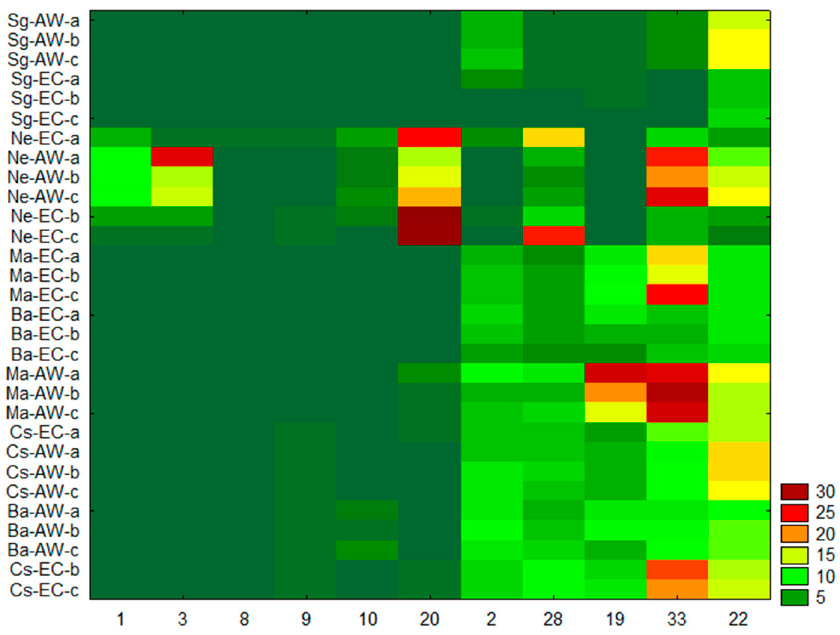
Figure 5. Two way-joining run on some selected esters (ppm). Sg, Sangiovese; Ma, Magliocco; Ba, Barbera; Cs, Cabernet-Sauvignon; Ne, Negroamaro. EC, strain EC1118; AW, strain AWRI796. 1: ethyl undec-10-enoate; 2: 3-methylbutyl acetate; 3: [(2E)-3,7-dimethylocta-2,6-dienyl] acetate; 8: methyl non-7-ynoate; 9: 2-phenylethyl acetate; 10: 3-hydroxy-2,2-dimethoxypropyl acetate; 19: ethyl decanoate; 20: ethyl dodecanoate; 22: ethyl acetate; 28: ethyl hexanoate; 33: ethyl octanoate.